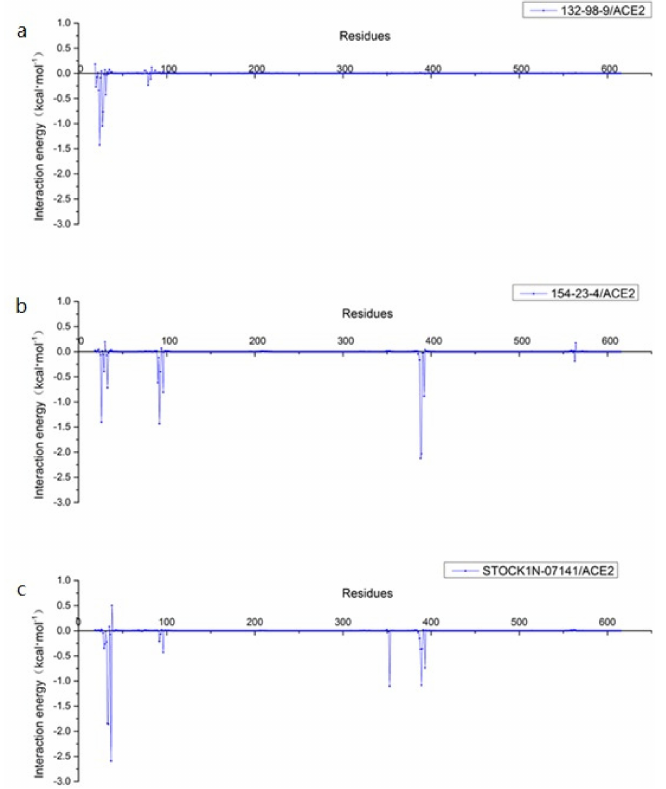
Figure 7. Contributions of residues calculated by decomposing the binding energy. ( a ) 132-98-9/ACE2,